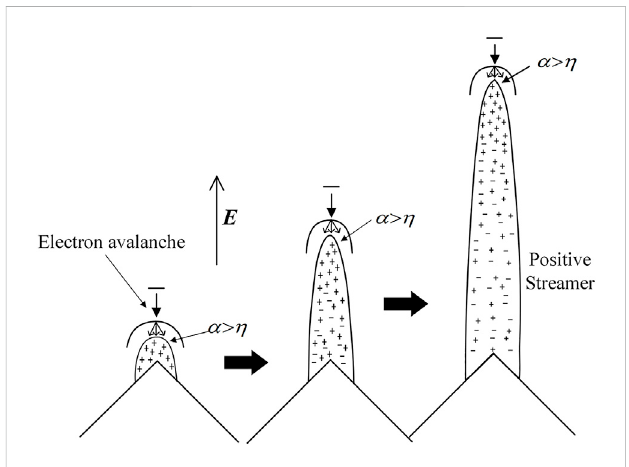
FIGURE 1 Formation of a positive streamer in the enhanced electric fi